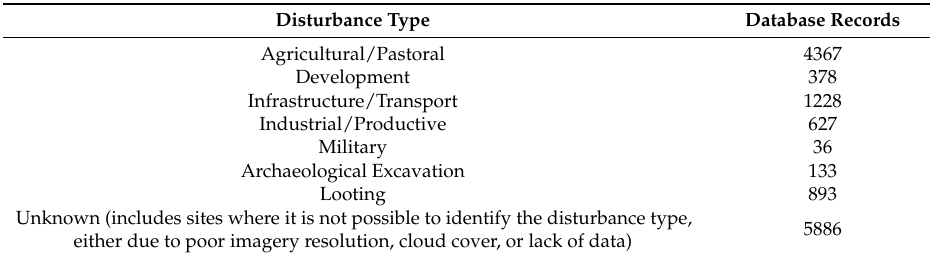
Figure 6. Distribution of EAMENA records with damage caused by agriculture recorded and grid squares with records entered by EAMENA superimposed on land-cover derived from data obtained via Google Earth engine: vegetation (MODIS NDVI, [54]) and areas of human activity based on night-time radiance data (VIRS, [55]). Table 3. Examples of disturbance types.